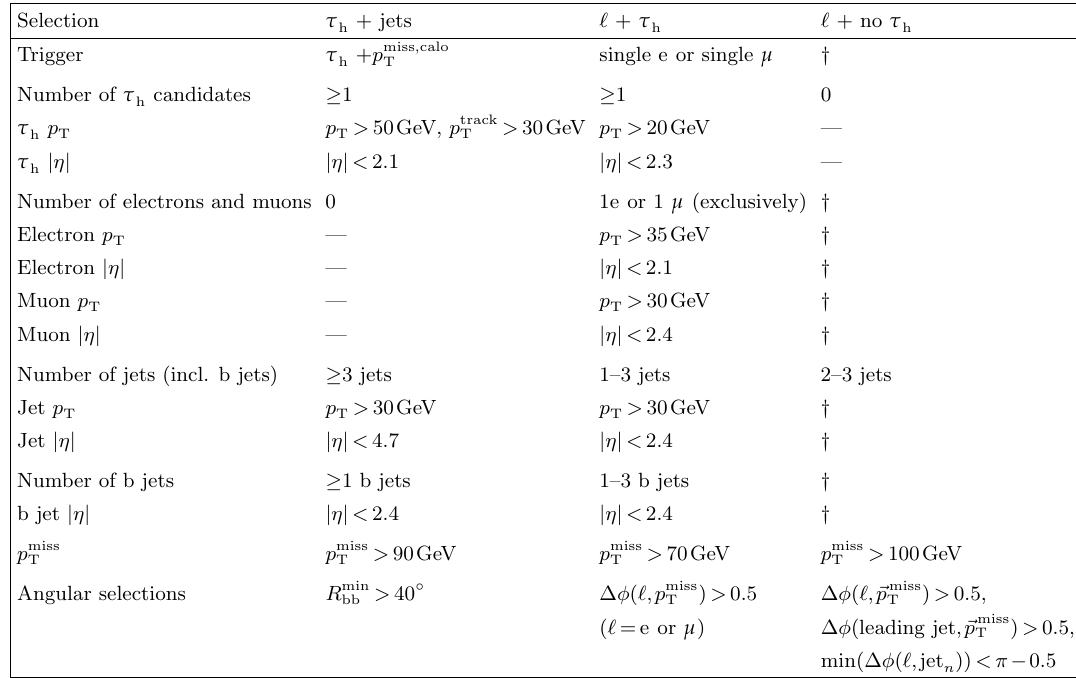
Table 1 . A summary of the event selection criteria applied in each (cid:12)nal state. The electrons, muons, t candidates and jets are required to be separated from each other by (cid:1) R > 0 : 5 in all h (cid:12)nal states. The symbol means that the selection is identical between ‘ + t y (cid:12)nal states. In all (cid:12)nal states, events with additional electrons or muons are vetoed as detailed in section 5. In this table, \b jets" refers to all jets passing the b jet identi(cid:12)cation, and jet any of the selected